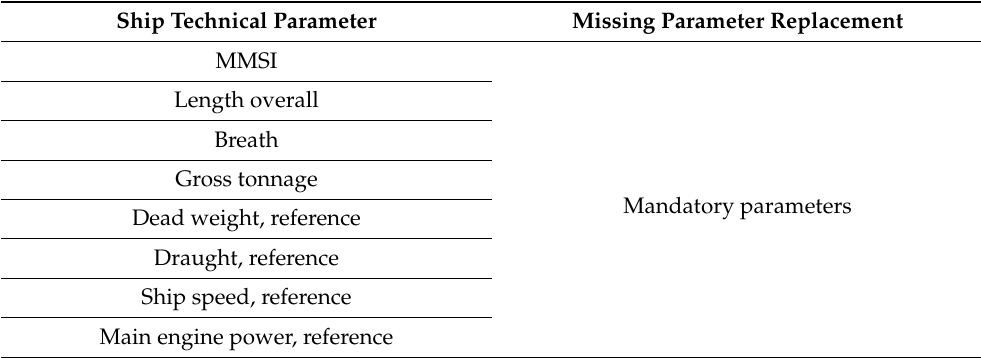
Table A1. Ship technical data required for energy use evaluation and replacement parameters that can be utilized if data are missing. Statistical values are determined based on data collected from RoPax ferries by Kristensen et al. in 2016